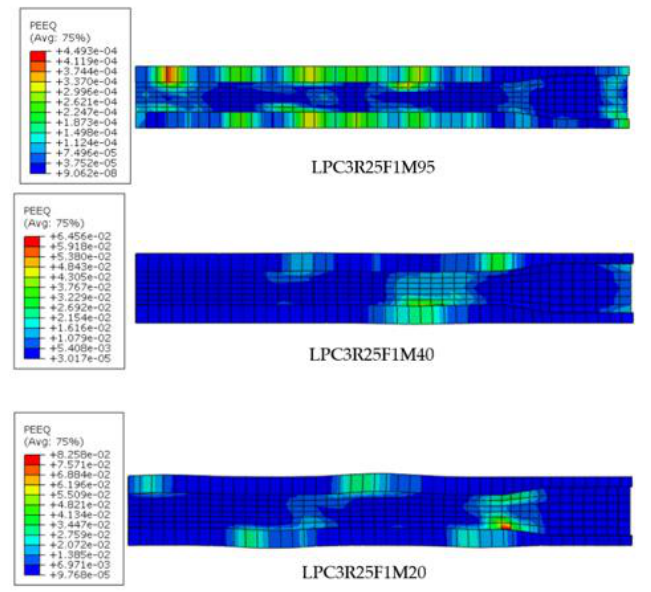
Figure 11. Damage level of the mortar at axial core strain of 2% under